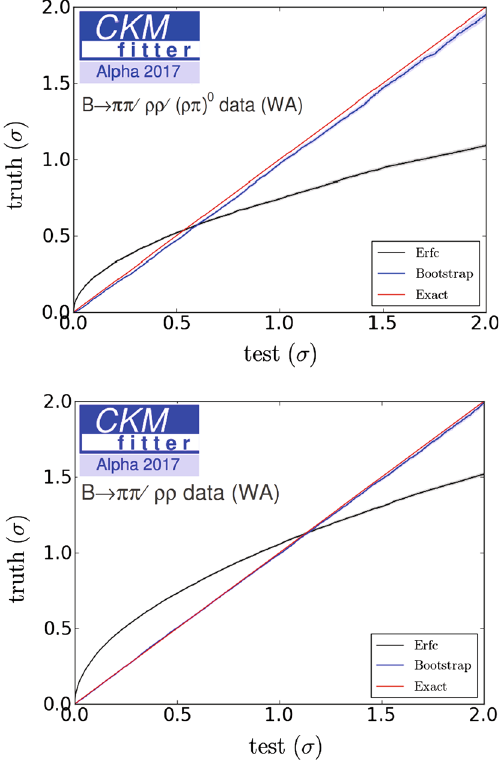
Fig. 19 Coverage test displaying the true significance as a function of the test significance using the bootstrap and Wilks-based approaches (the latter being denoted Erfc) for the combined extraction of α ( top ) and for the partial combination based on B → ππ and B → ρρ only ( bottom ) value with exact coverage corresponds to a diagonal straight line, over-coverage (under-coverage) happens if the curve is above (below) this diagonal. In our particular case,